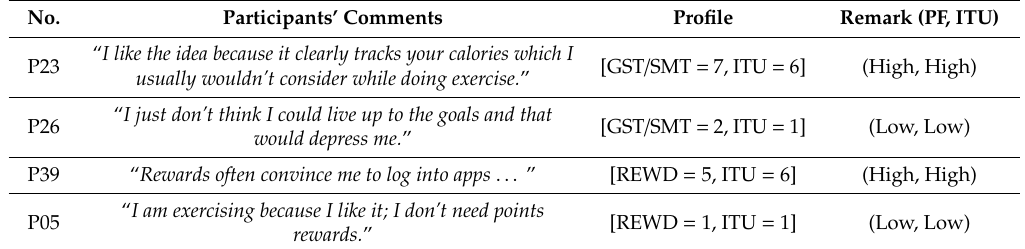
Table 4. Participants’ comments on Goal-Setting / Self-Monitoring and Reward features and receptiveness profile.